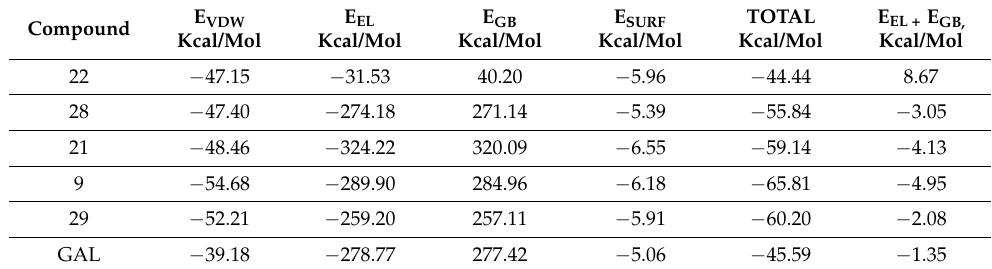
Table 2. Energy components (E VDW— van der Waals and E EL— electrostatic interaction energies; E GB— polar and E SURF —non-polar solvation energies solvation energies; TOTAL—total energy of binding) of the ligands complexed with the enzyme. The reference AChE inhibitor is